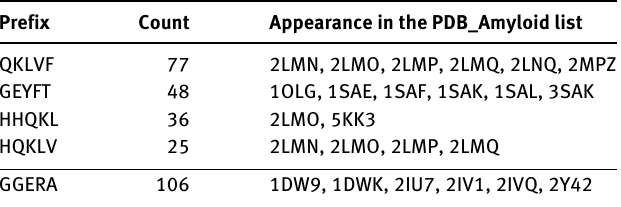
Table 1: The four most frequent prefixes in the 𝛽 -sheets of the NMR-identified entries of the PDB_Amyloid list, plus the most frequent prefix (GGERA) in the X-ray crystallography identified entries of